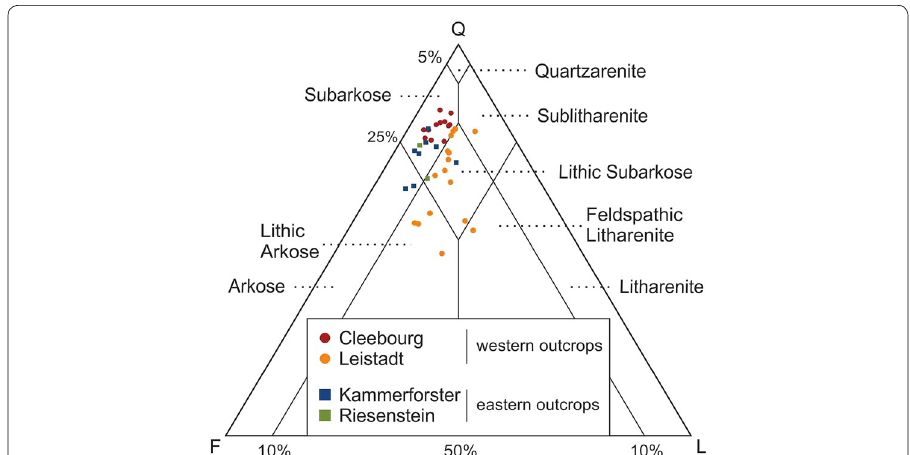
Fig. 3 Modal composition of sandstone samples from the different locations in a QFL diagram, after McBride (1963). The sandstone compositions of Leistadt, Riesenstein, and Kammerforster are adopted from Soyk (2015)